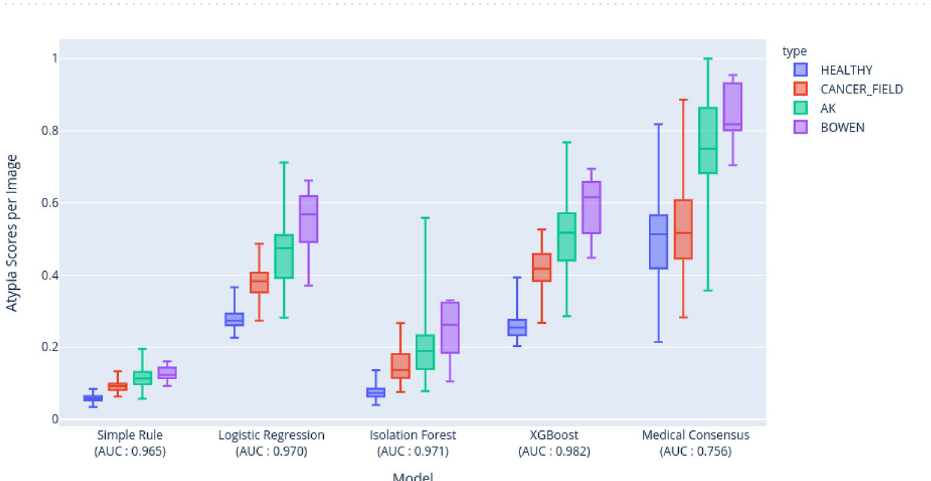
Figure 3. Example of atypia detections (in red) and normal nulcei (in green) with the simple rule-based atypia definition for one AK lesion ( a ) and its perilesional field of cancerization ( b ).